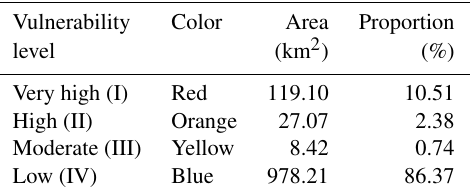
Table 9. The vulnerability level, area, and proportion for each vul- nerability